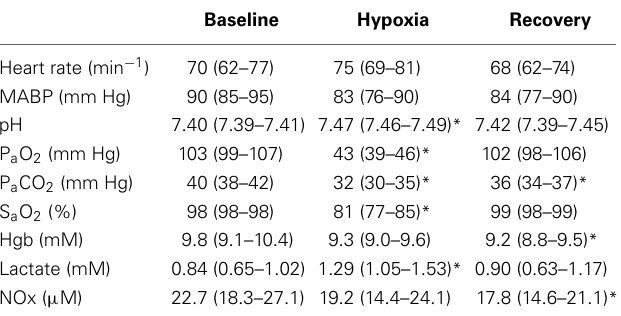
Table 1 | Effect of hypobaric hypoxia.